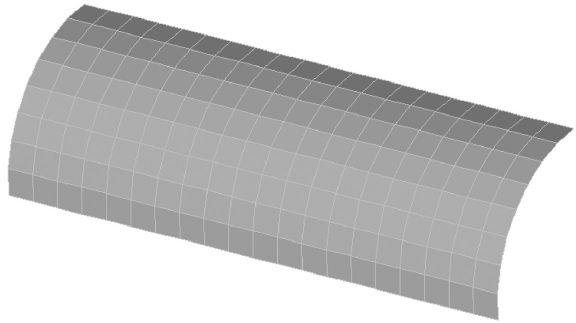
Fig. 12. Finite element mesh of an octant of the cylinder.